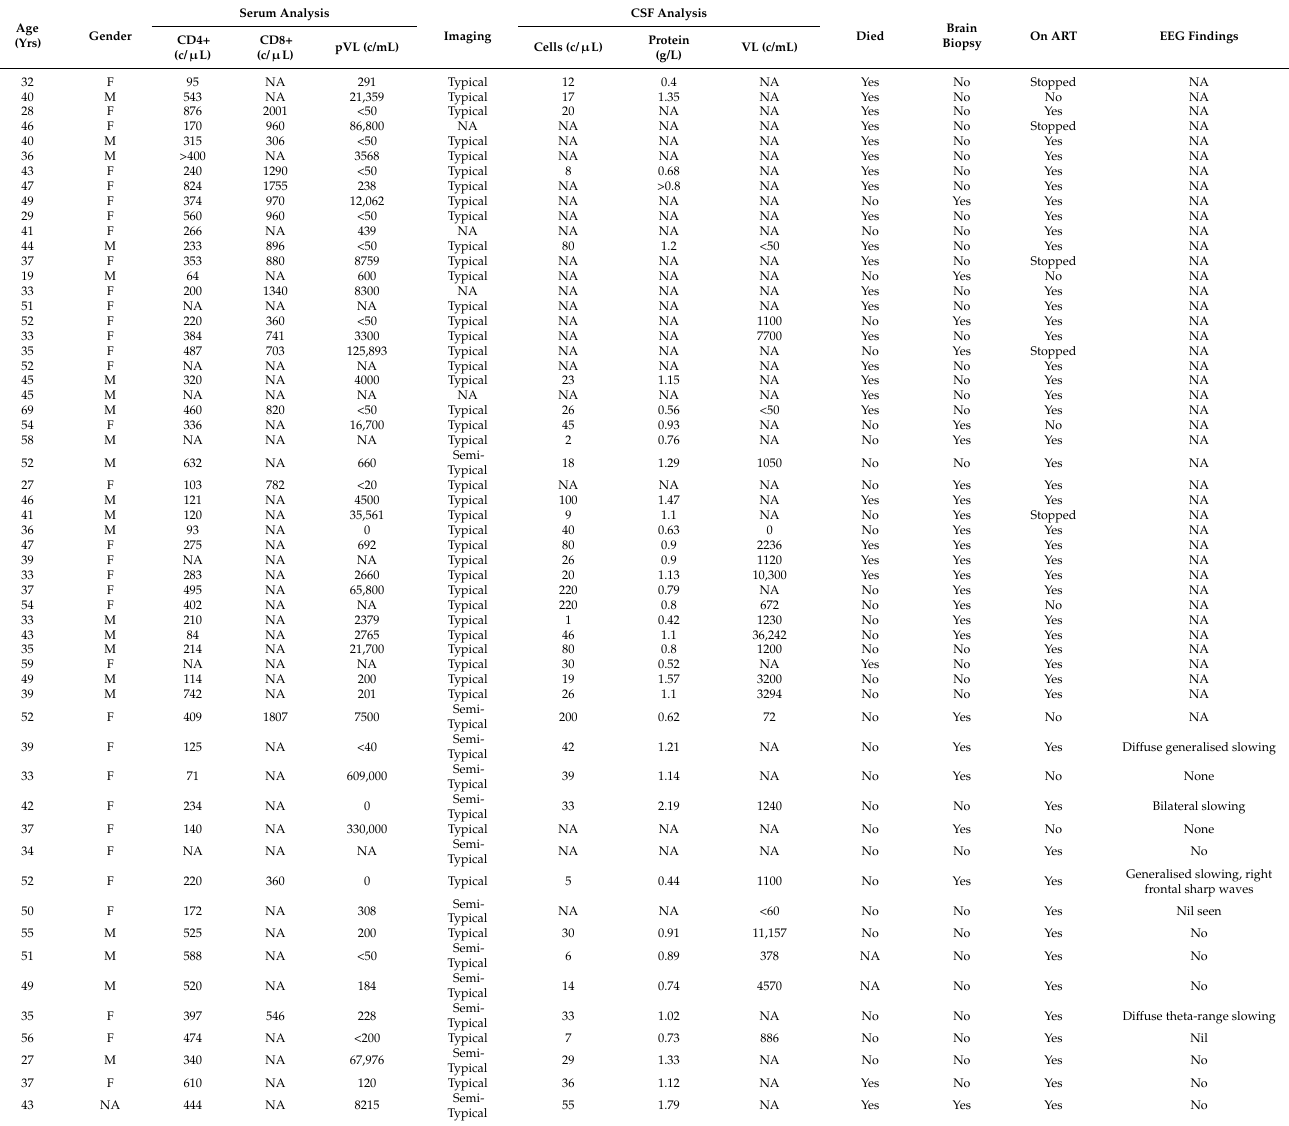
Table 1. Demographics, baseline characteristics and outcomes of 57 patients with CD8+ Encephali- tis